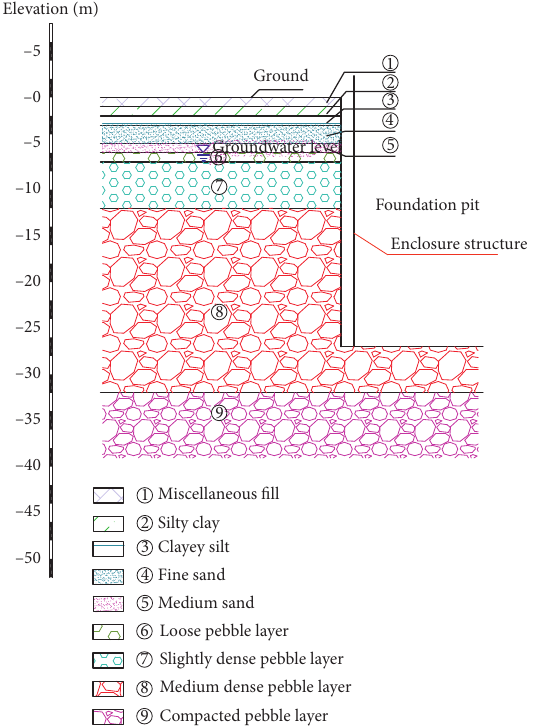
Figure 12: Geological profile of the strata and foundation pit.